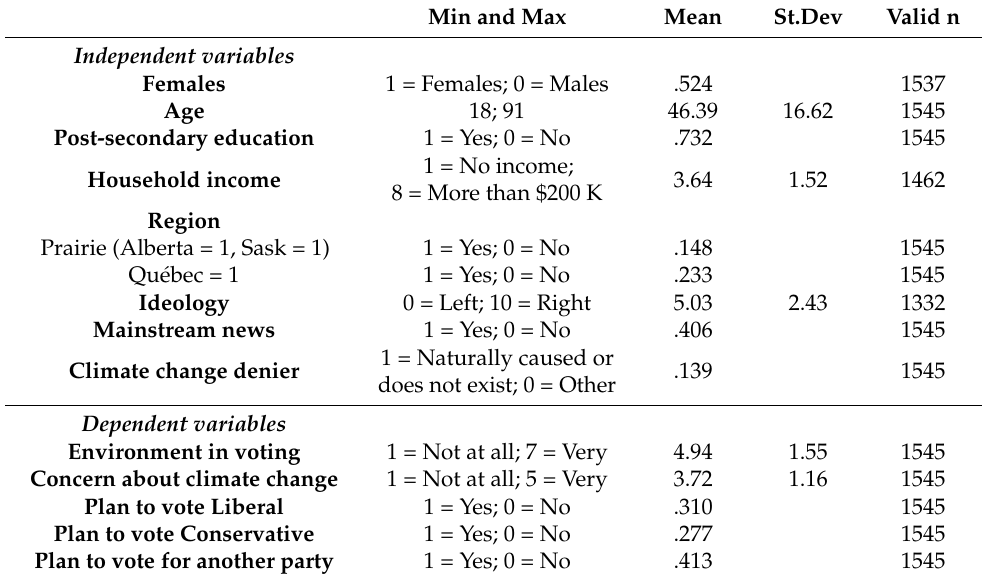
Table 1. Descriptive